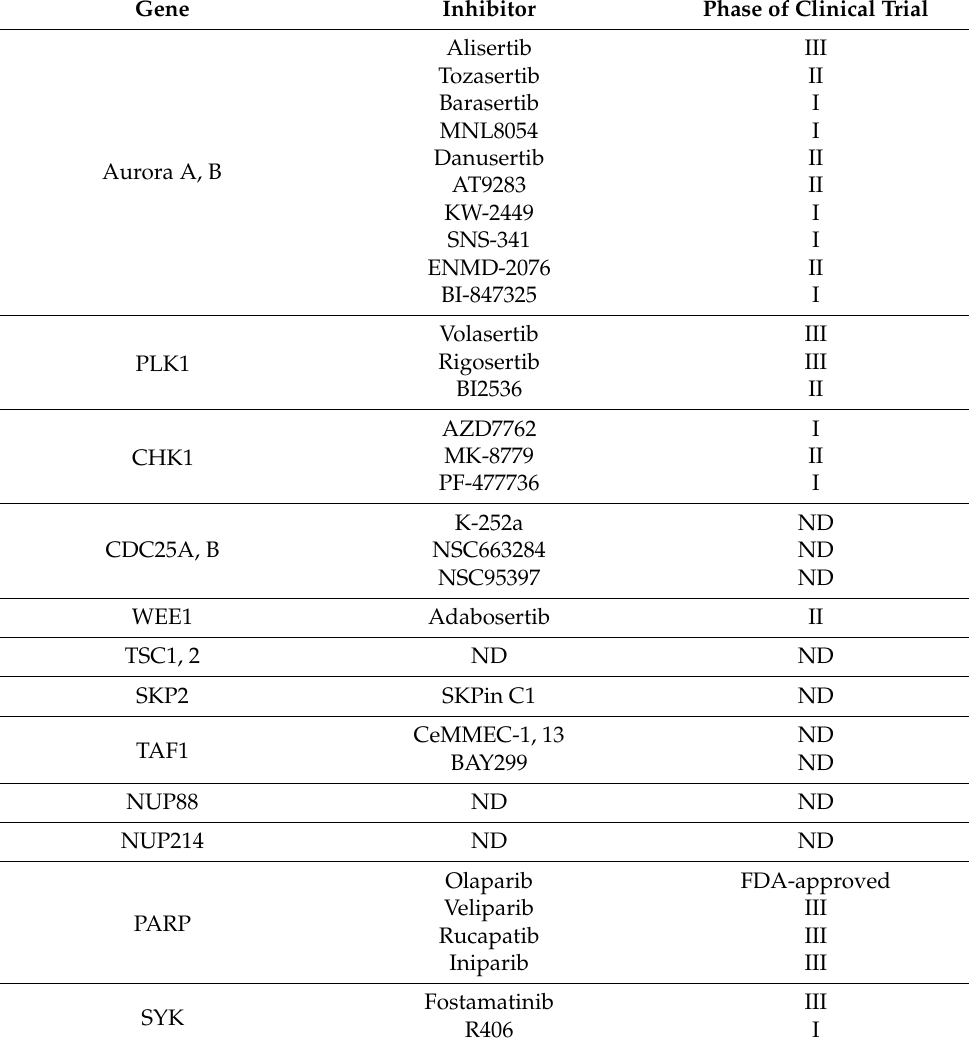
Table 1. Genes whose inactivation exerts synthetic lethality in the presence of RB1 deficiency, and representative inhibitors to the gene products and phase of clinical trials. ND: no data. The information was obtained by searching online accessible catalogues provided by Selleck, Santa Cruz and